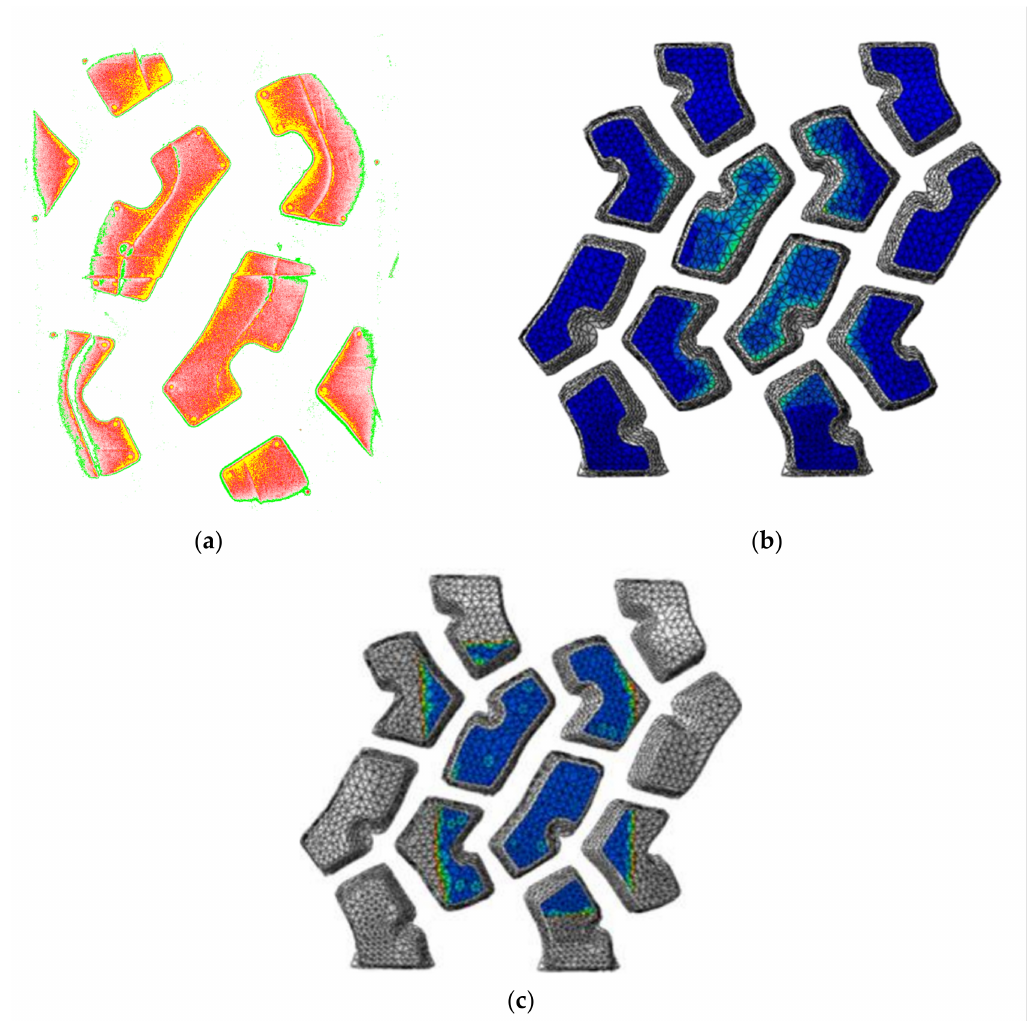
Figure 12. Contact patch comparison: experimental pressure distribution ( a ), FE contact pressure distribution ( b ), and contact opening plot ( c